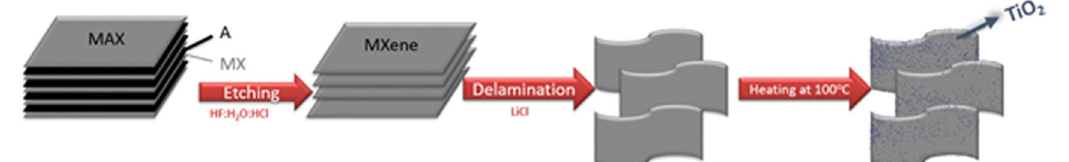
Fig. 7 Schematics of experimentation. Synthesis and oxidation of free-standing Ti 3 C 2 T x MXene fi lm to get HT-Ti 3 C 2 T x MXene fi